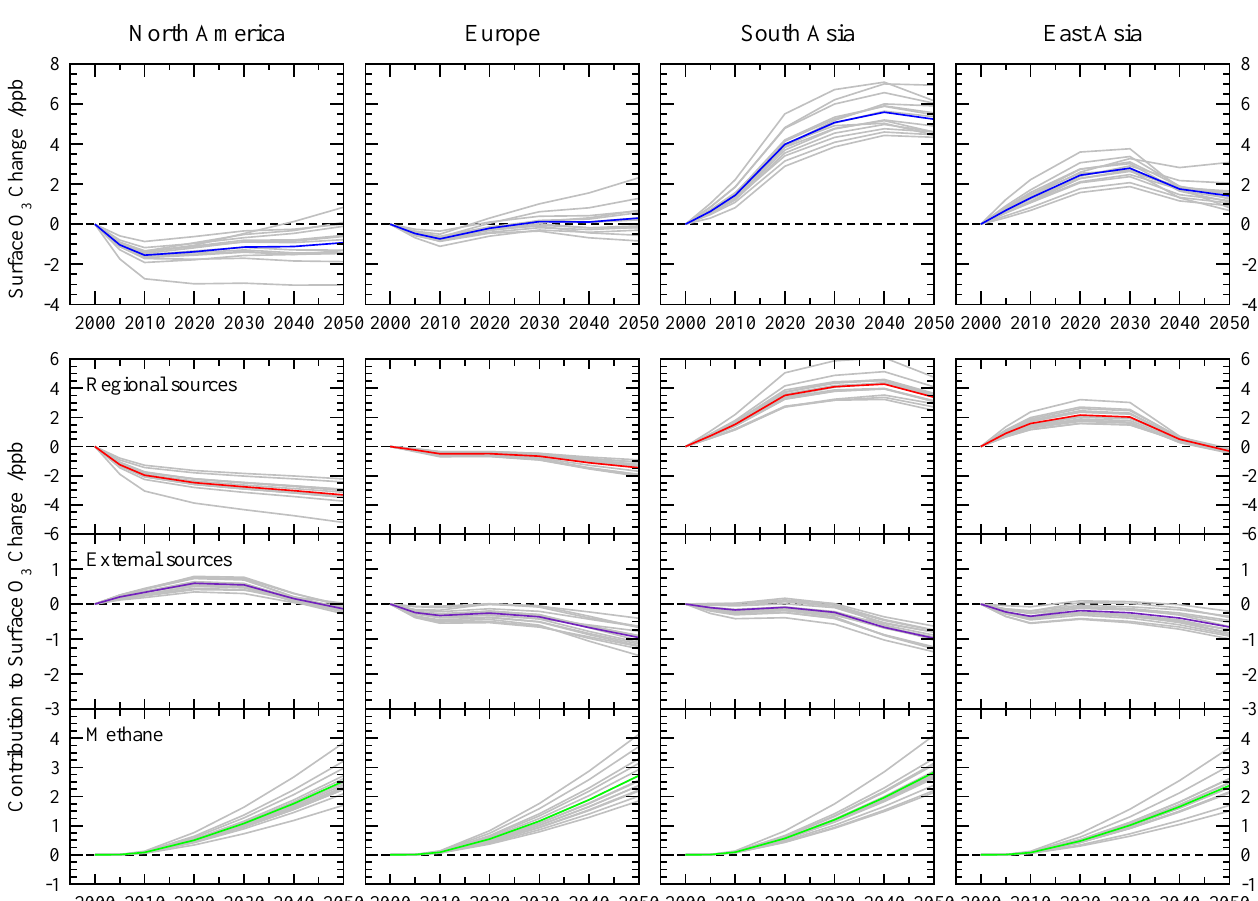
Fig. 10. As Fig. 9 for the RCP 8.5